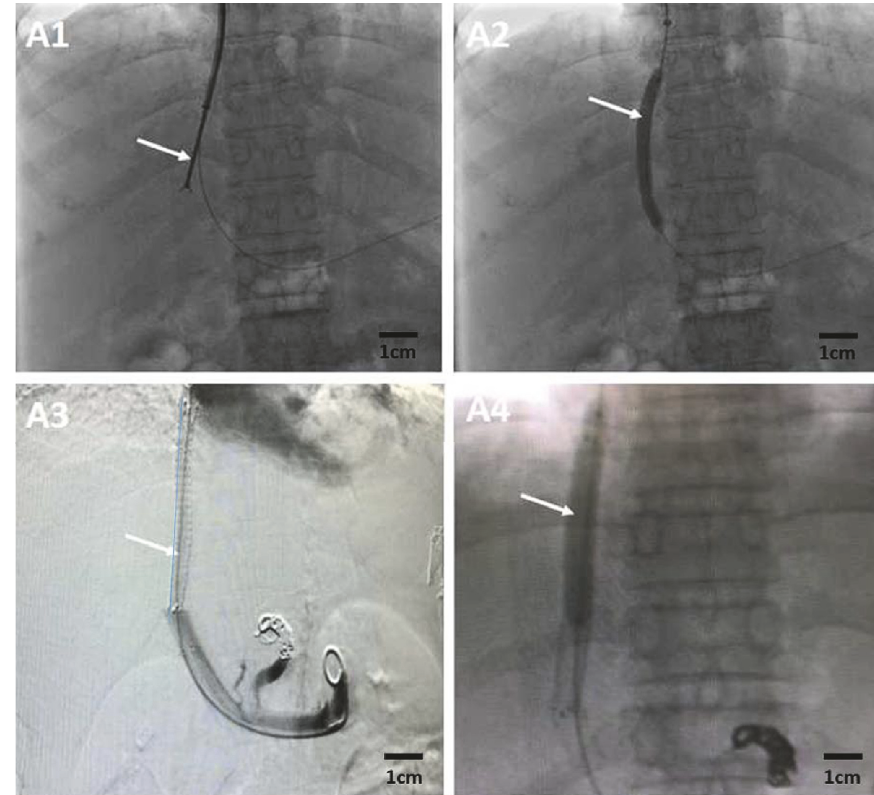
Figure 1: Procedure for obtaining liver tissue of preshunt channel. A1: A RUPS-100 liver access set was delivered into the portal vein. Liver tissueoftheshuntwasobtainedbeforeballoondilation(whitearrow).A2:Balloondilationoftheshunt(whitearrow).A3:Stentwasimplanted among the inferior vena cava, hepatic vein, preshunt channel, and portal vein to establish a shunt (white arrow). A4: Balloon dilation of the stent (white